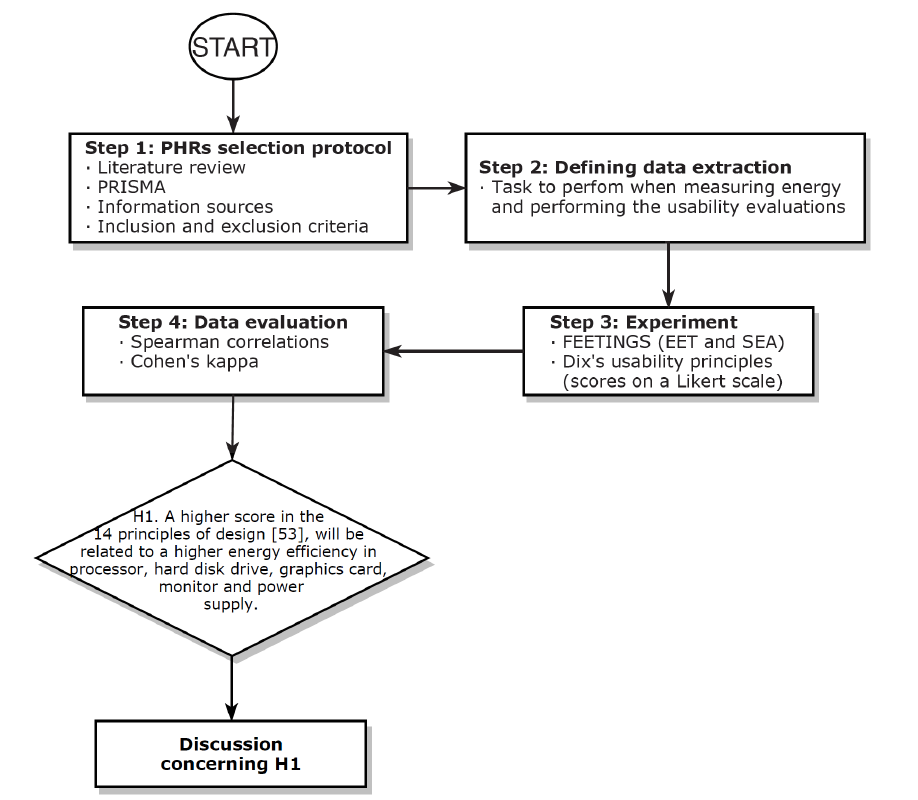
Figure 1. Research flow